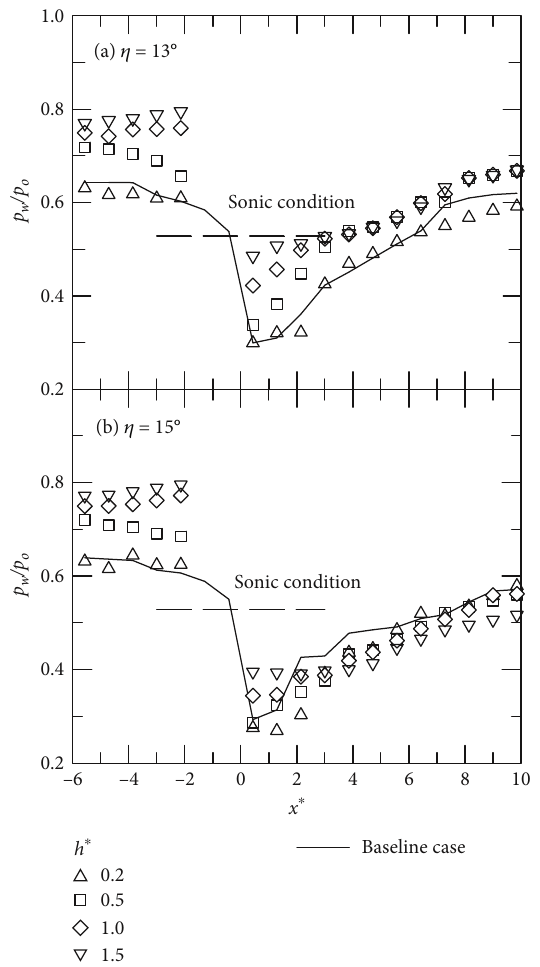
Figure 4: Mean surface pressure distribution for M = 0 : 83